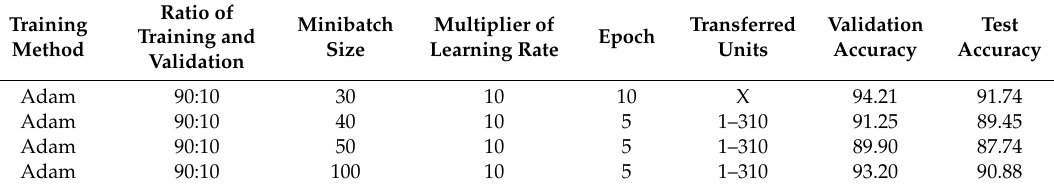
Table 10. Performance of EECGNet on CU-ECG.